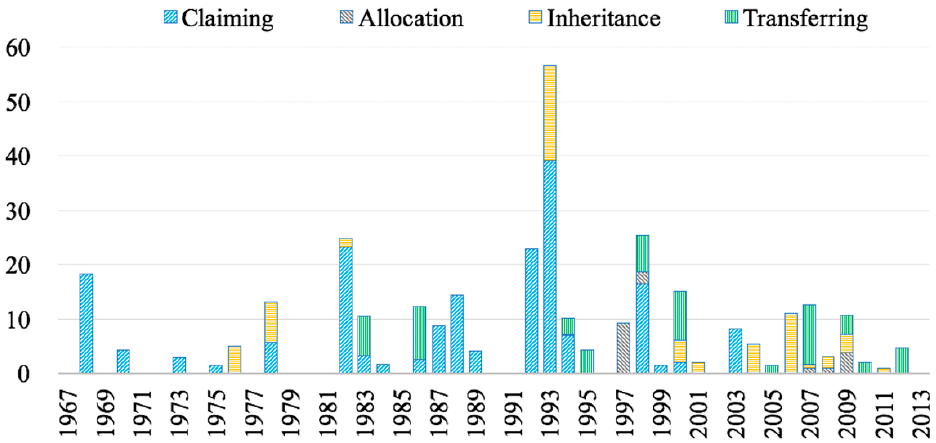
Figure 6. Sample households that obtained paddy fields. Source : Household survey.